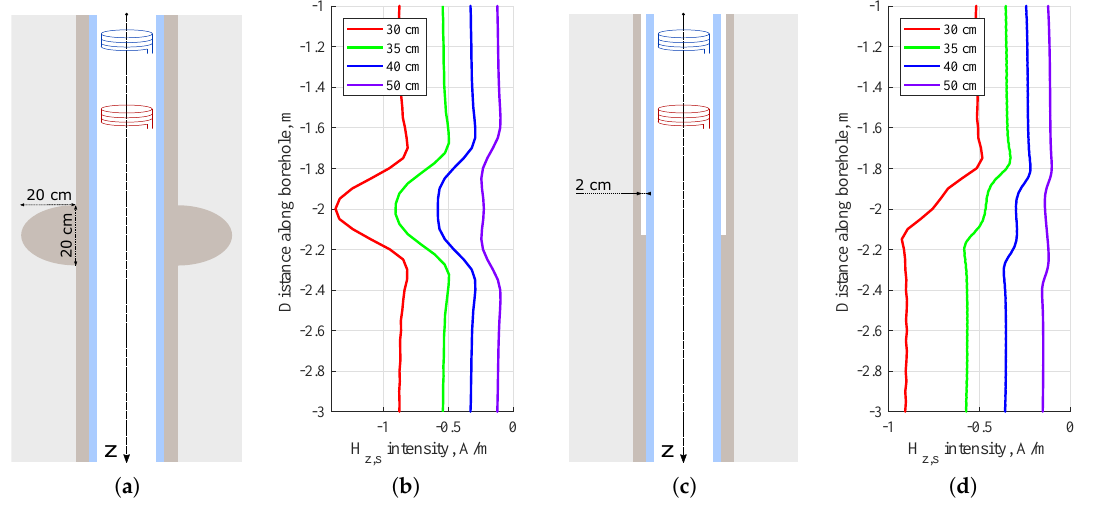
Figure 9. ( a ) The model of a cavity filled with a cement, ( b ) logging signals at the frequency of 1 kHz cross a cavity filled with cement, ( c ) the model of a cement with 2 cm debonding, and ( d ) logging signals at the frequency of 1 kHz cross a debonding